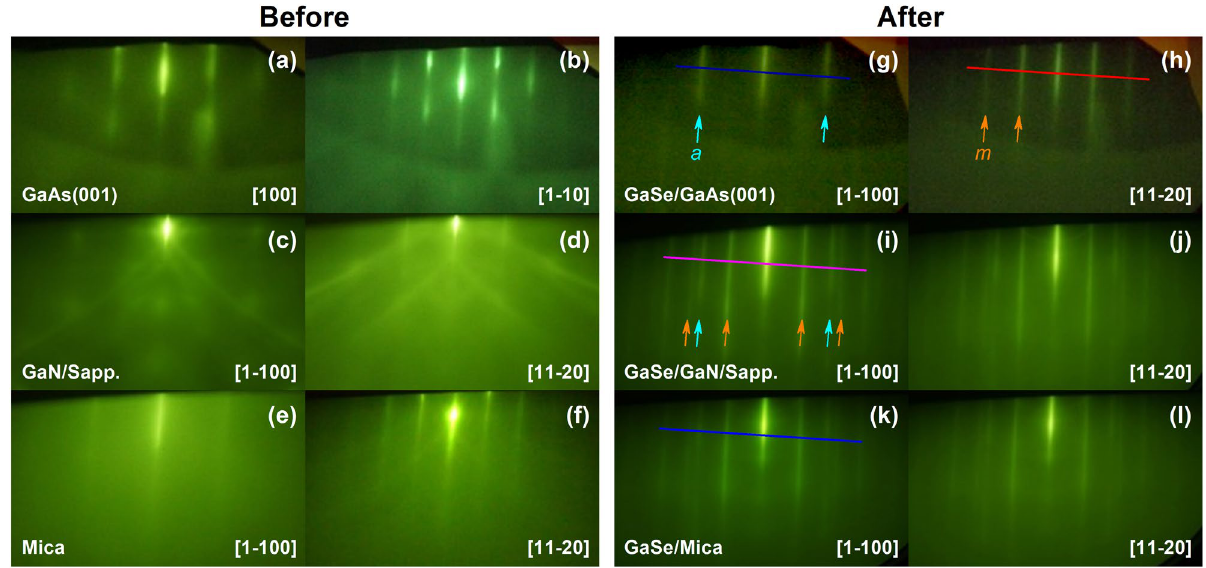
Figure 1. RHEED patterns monitored before ( a )–( f ) and after ( g )–( l ) the GaSe deposited on various